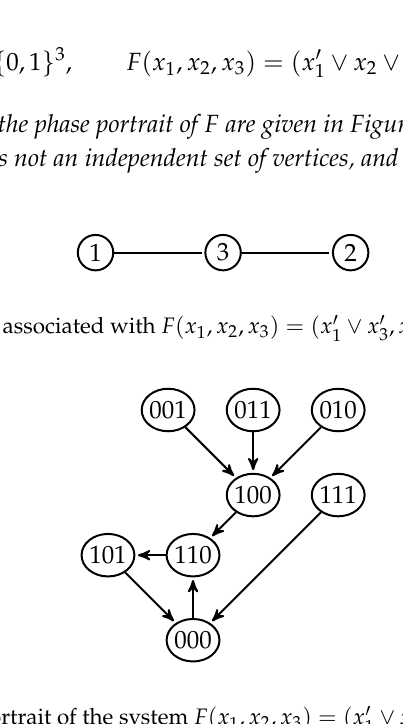
Figure 10. Phase portrait of the system F ( x 1 , x 2 , x 3 ) = ( x (cid:48)